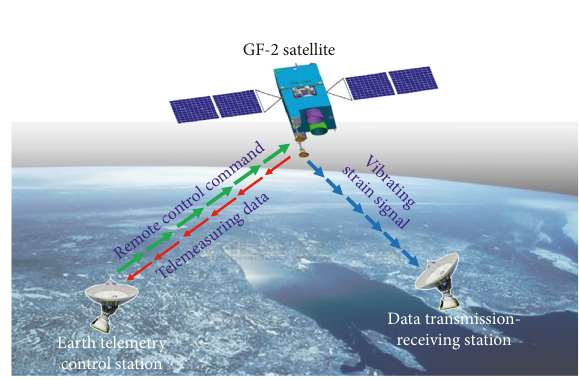
Figure 1: Diagram of the on-orbit vibration data acquisition